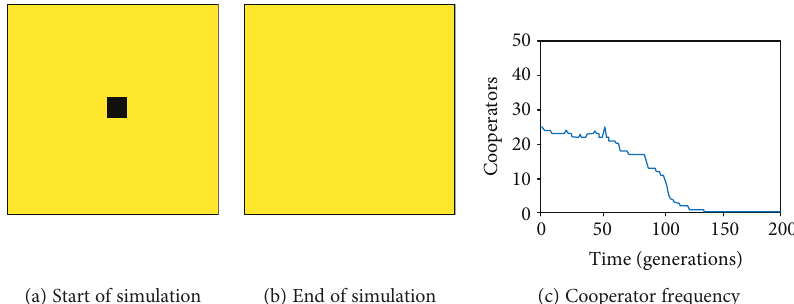
Figure 9: Evolution of cooperator frequency (black) when starting with an initial 5 × 5 cooperator cluster within a 50 × 50 grid of defectors